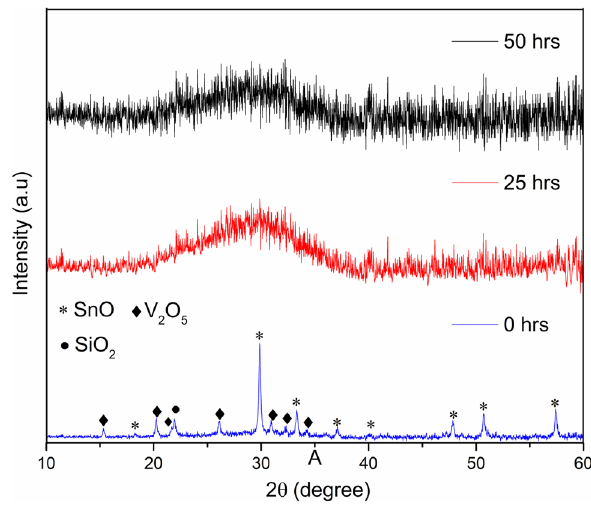
Fig. 1 XRD powder patterns of SnO–V2O5–SiO2 glass anode for several hours ball milling